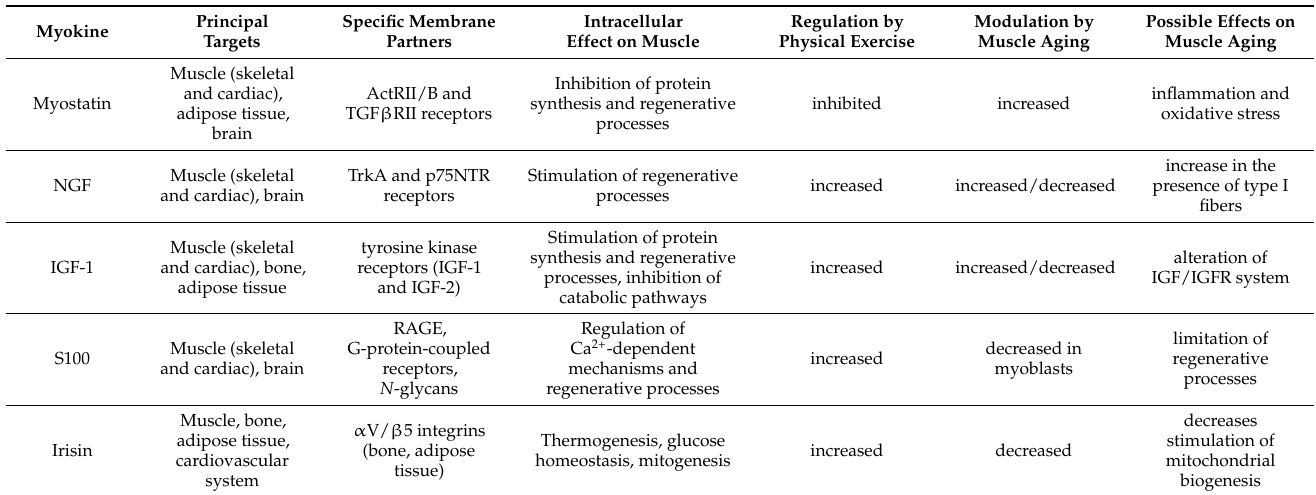
Table 1. Myokines linked to senescence-related